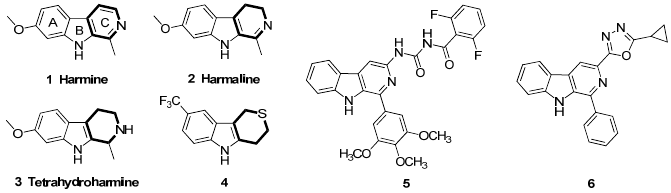
Figure 1. The structure of the β -carboline alkaloids and their